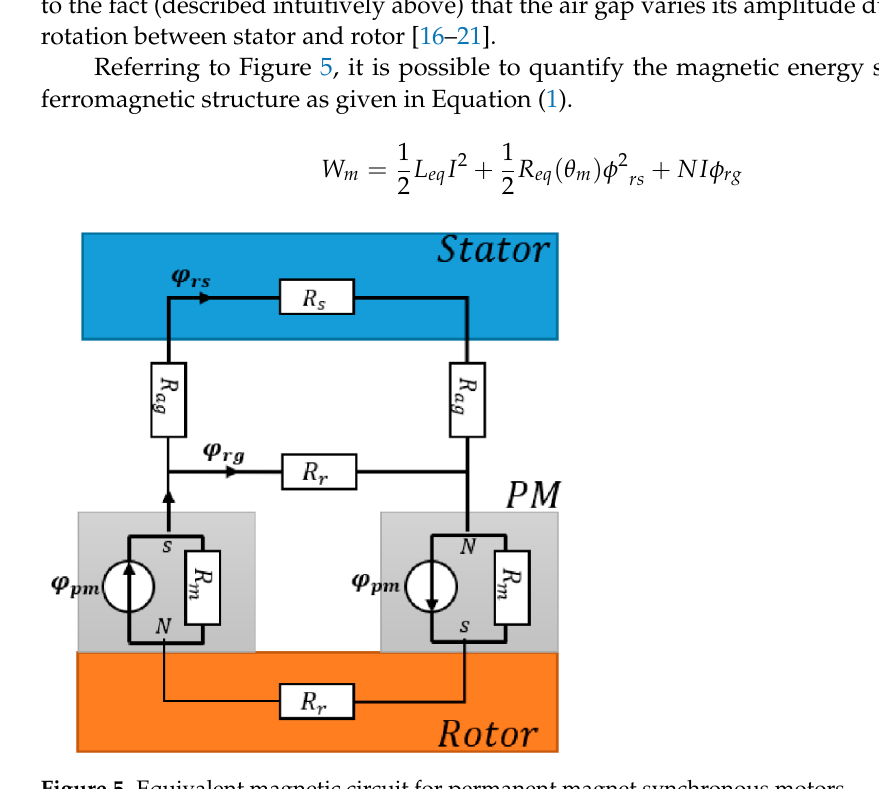
Figure 5. Equivalent magnetic circuit for permanent magnet synchronous motors. ergized and not energized conditions. With L eq we denote the stator inductance of